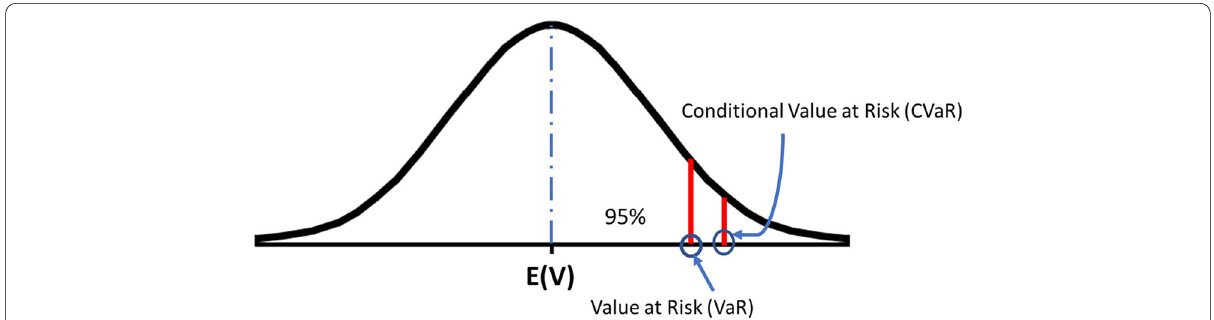
Fig. 2 Generalized cost distribution under a rehabilitation